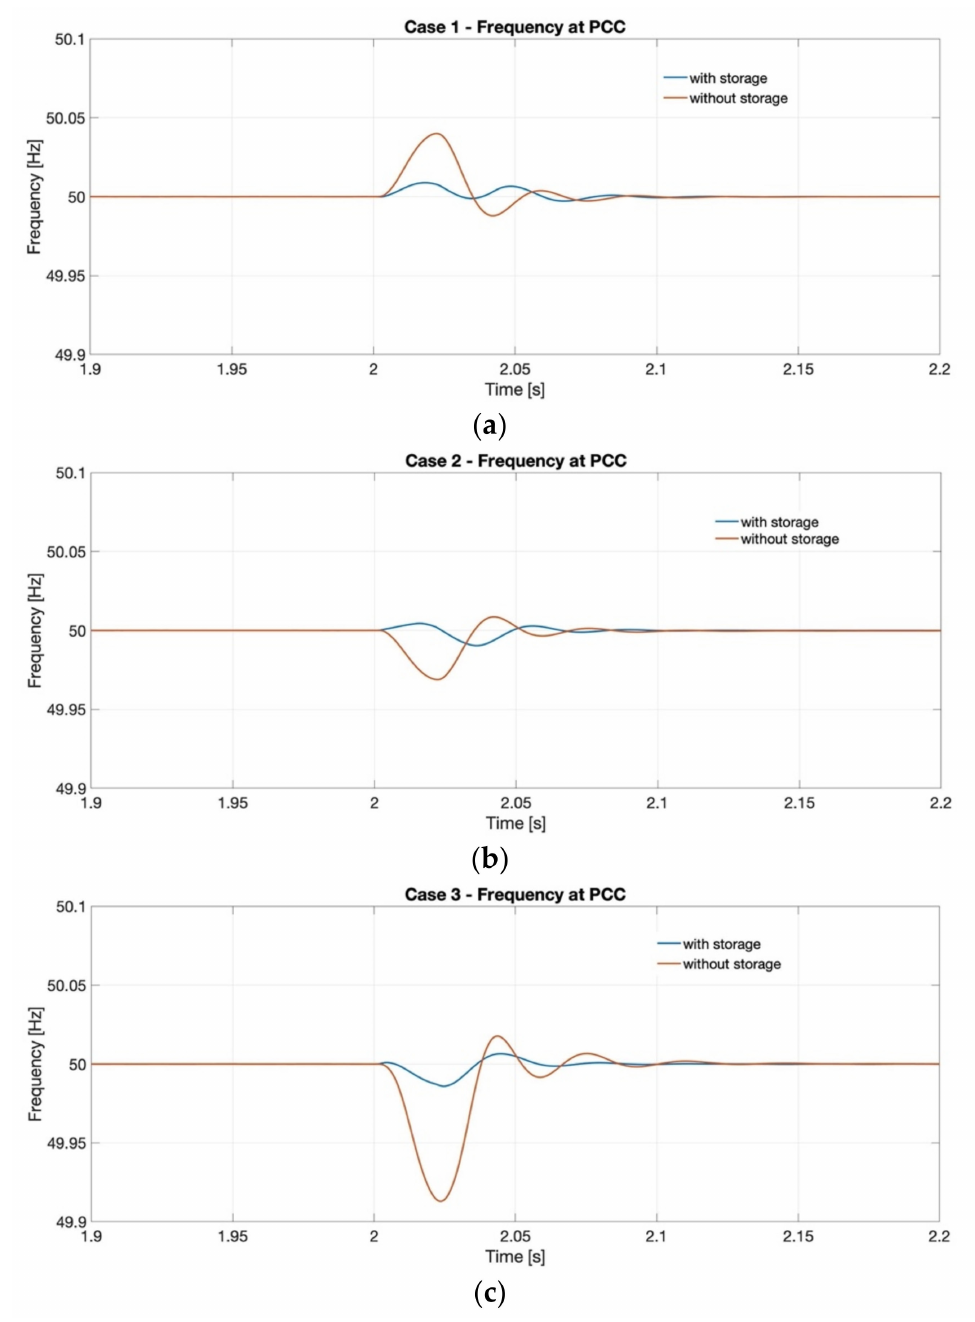
Figure 10. Frequency behavior at PCC: ( a ) Case 1, ( b ) Case 2 and ( c ) Case 3. In order to provide an evaluation of the active power oscillation amplitude at the PCC for the investigated simulation scenarios, the relative active power oscillation amplitude is presented in Figure 11a in terms of the ∆ P / P stabilized parameter. It is specified that ∆ P is the difference between the maximum and minimum active power value across the transient occurring at the PCC, while P stabilized is the stabilized value subsequent the step occurrence (see Figure 8). It is highlighted that the evolutionary trends varying the WEC power step are characterized by a strong reduction of the ∆ P / P stabilized values in case the HESS is integrated. Moreover, it is noticeable that coupling the HESS enables a more reduced slope of the trend if compared to the no-storage